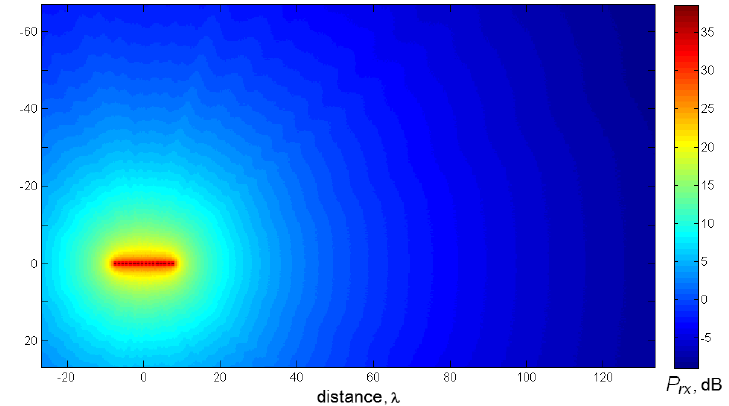
Fig. 2. Ensemble power field P rx (  , r ). Establishment of the spherical wave front. For a linear grid (a line) of UWB chaotic sources, the received signal power P